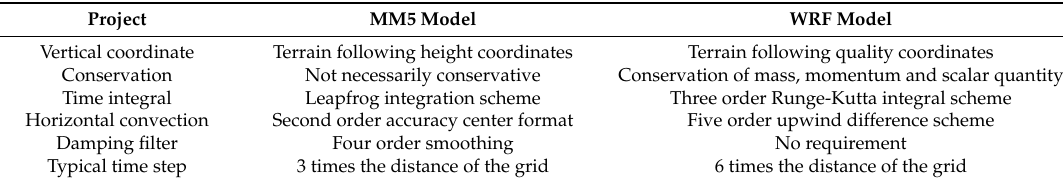
Table 14. Comparison of MM5 and WRF